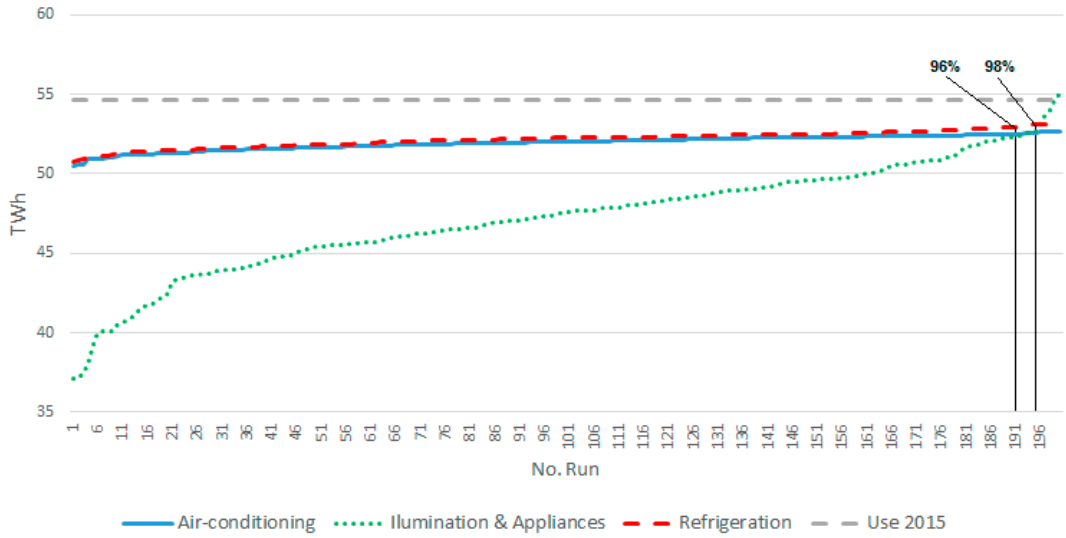
Figure 7. Estimated energy use by using efficient devices and decreasing their time of use upon the Mexican residential sector.